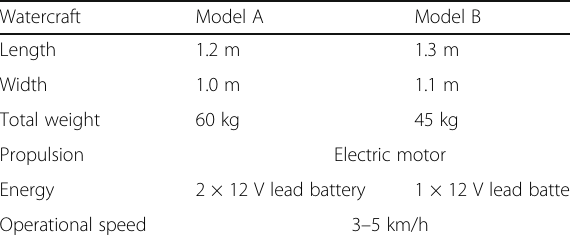
Table 1 Specifications of the developed unmanned watercraft Watercraft Model A